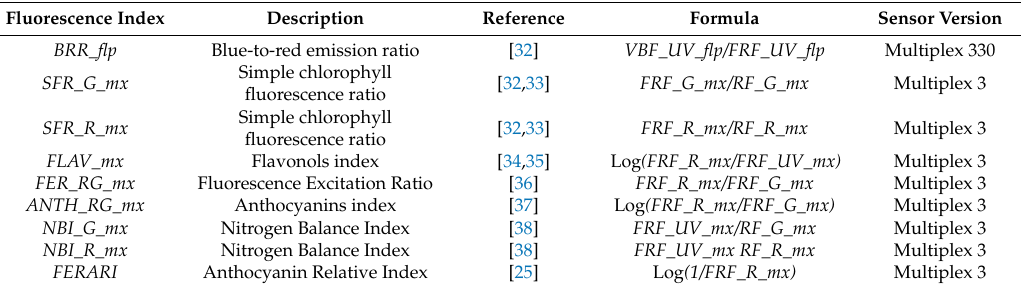
Table 2. Description of the fluorescence indices used in this